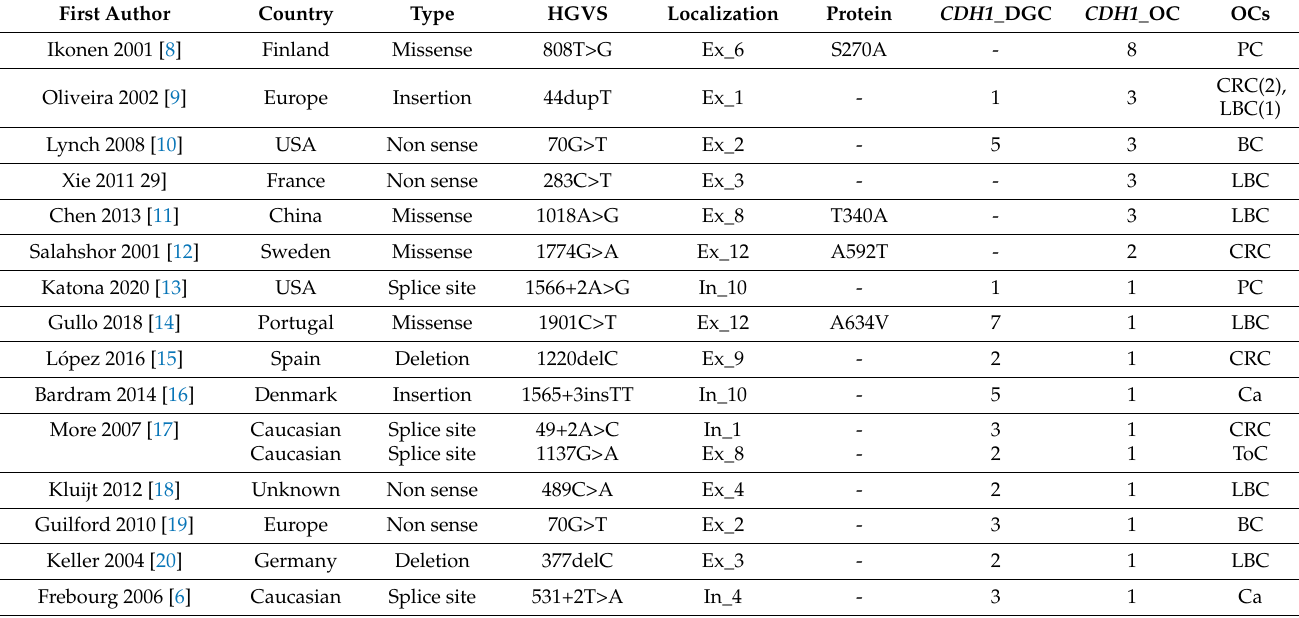
Table 1. List of CDH1 germline mutations identified in non-gastric cancers. In BC series, histotype was not reported (abbreviations: HGVS: Human Genome Variation Society nomenclature; DGC: diffuse gastric cancer; OC: other cancer; UK: United